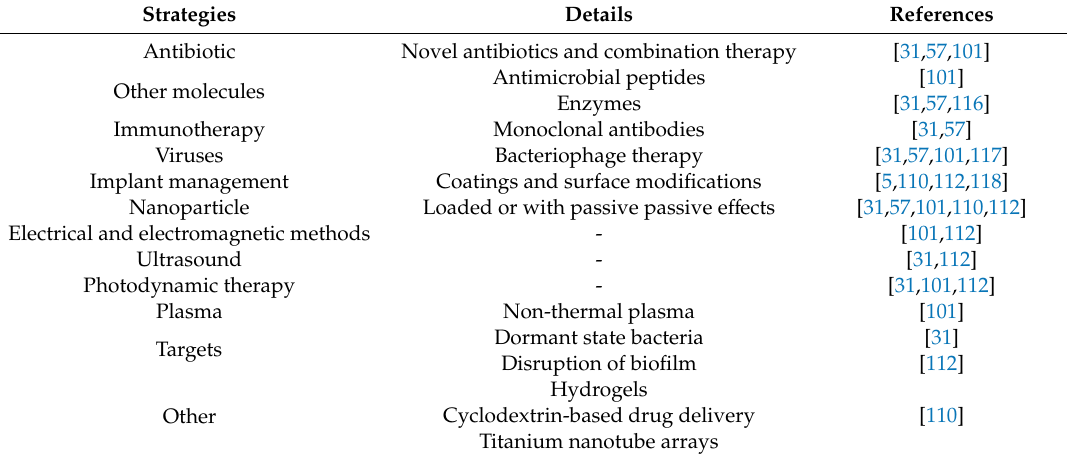
Table 1. Summary of di ff erent strategies to prevent and / or treat biofilm infections discussed in recent